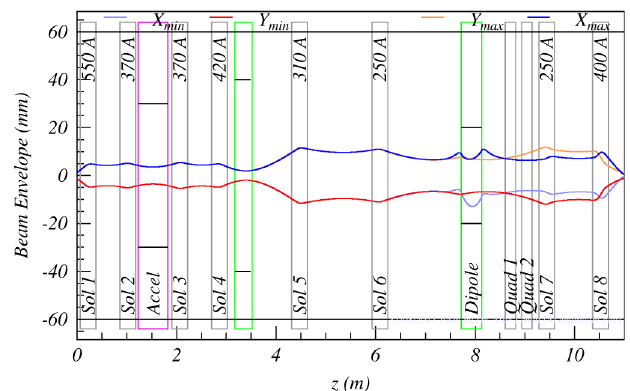
FIG. 15. 4 He þ 50 keV 5 mA (no postacceleration, 250 W, neutralization 90%) beam envelopes through the solid-target station beam line. The two high-energy quadrupoles are shown but not used in the present